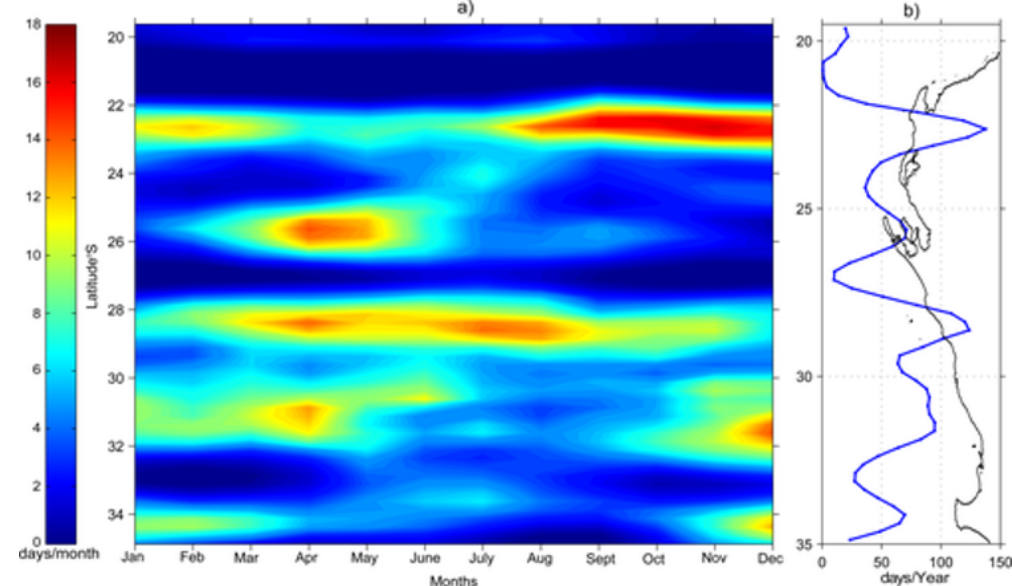
Figure 22. Climatological analysis of sporadic upwelling events. (a) Hovmöller (latitude versus time) diagram of the mean number of “upwelling days” (CUI > 15md − 1 during 3d or more) per month and (b) mean number of upwelling days per year, recorded from 1995– 2010 (from Rossi et al.,